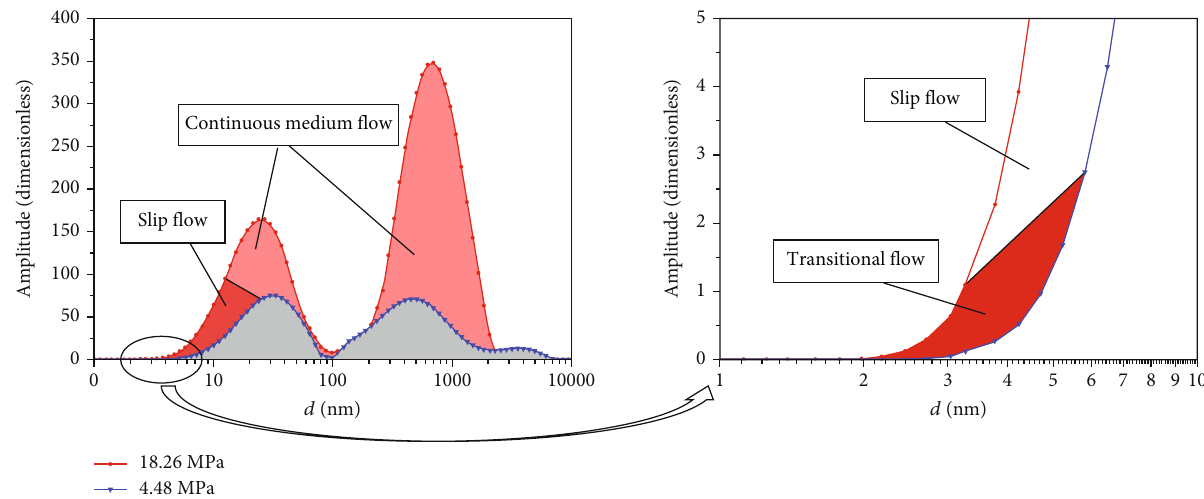
Figure 4: The amplitude distribution of the NMR signal corresponding to the pores of each scale under two pressure states at the beginning and end of the experiment (a) Full scale pore diameter distribution. (b) A magni fi ed view of pore diameter 1-10 nm.